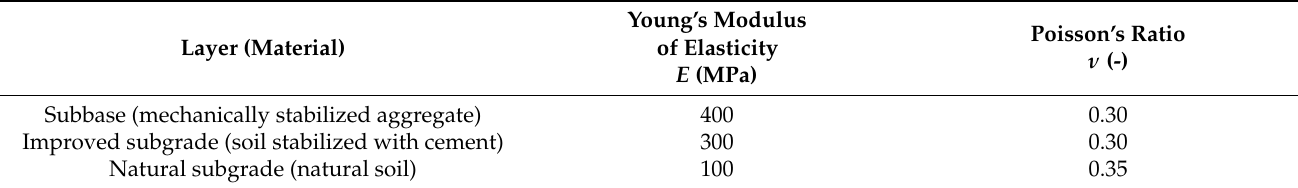
Table 4. Material parameters of lower pavement